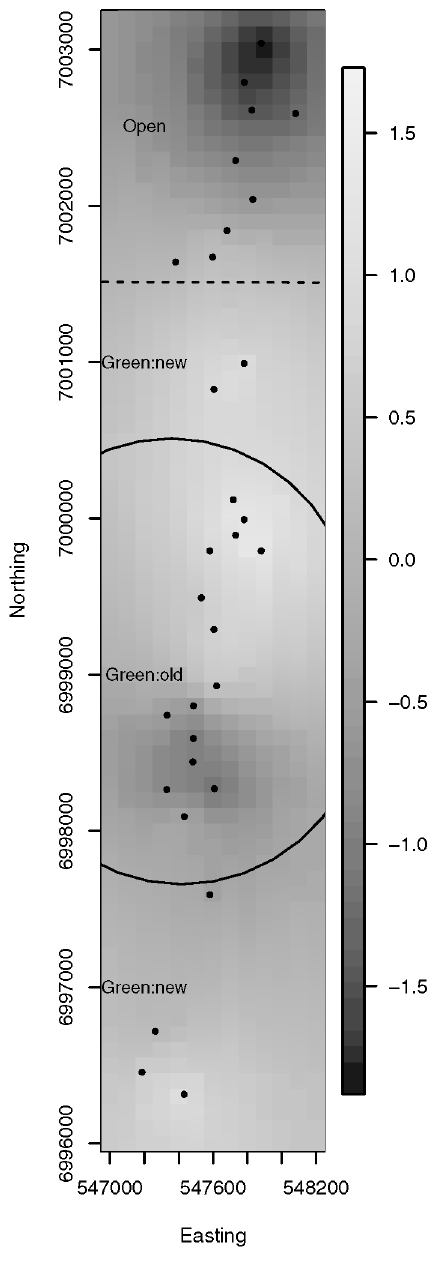
Fig 5. Posterior mean spatial random effects surface for MNP10. Each grid cell is 100 × 100m.